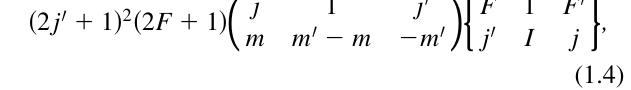
TABLE I. For I ¼ 7 = 2 , the probability p j 4 ; M i , remains in the F ¼ 4 hyperfine initially in the state S 1 = 2 level after being pumped with light tuned to the transition S F ¼ 4 ! P , F 0 that is linearly polarized with the axis of j 0 polarization parallel to z . P j 0